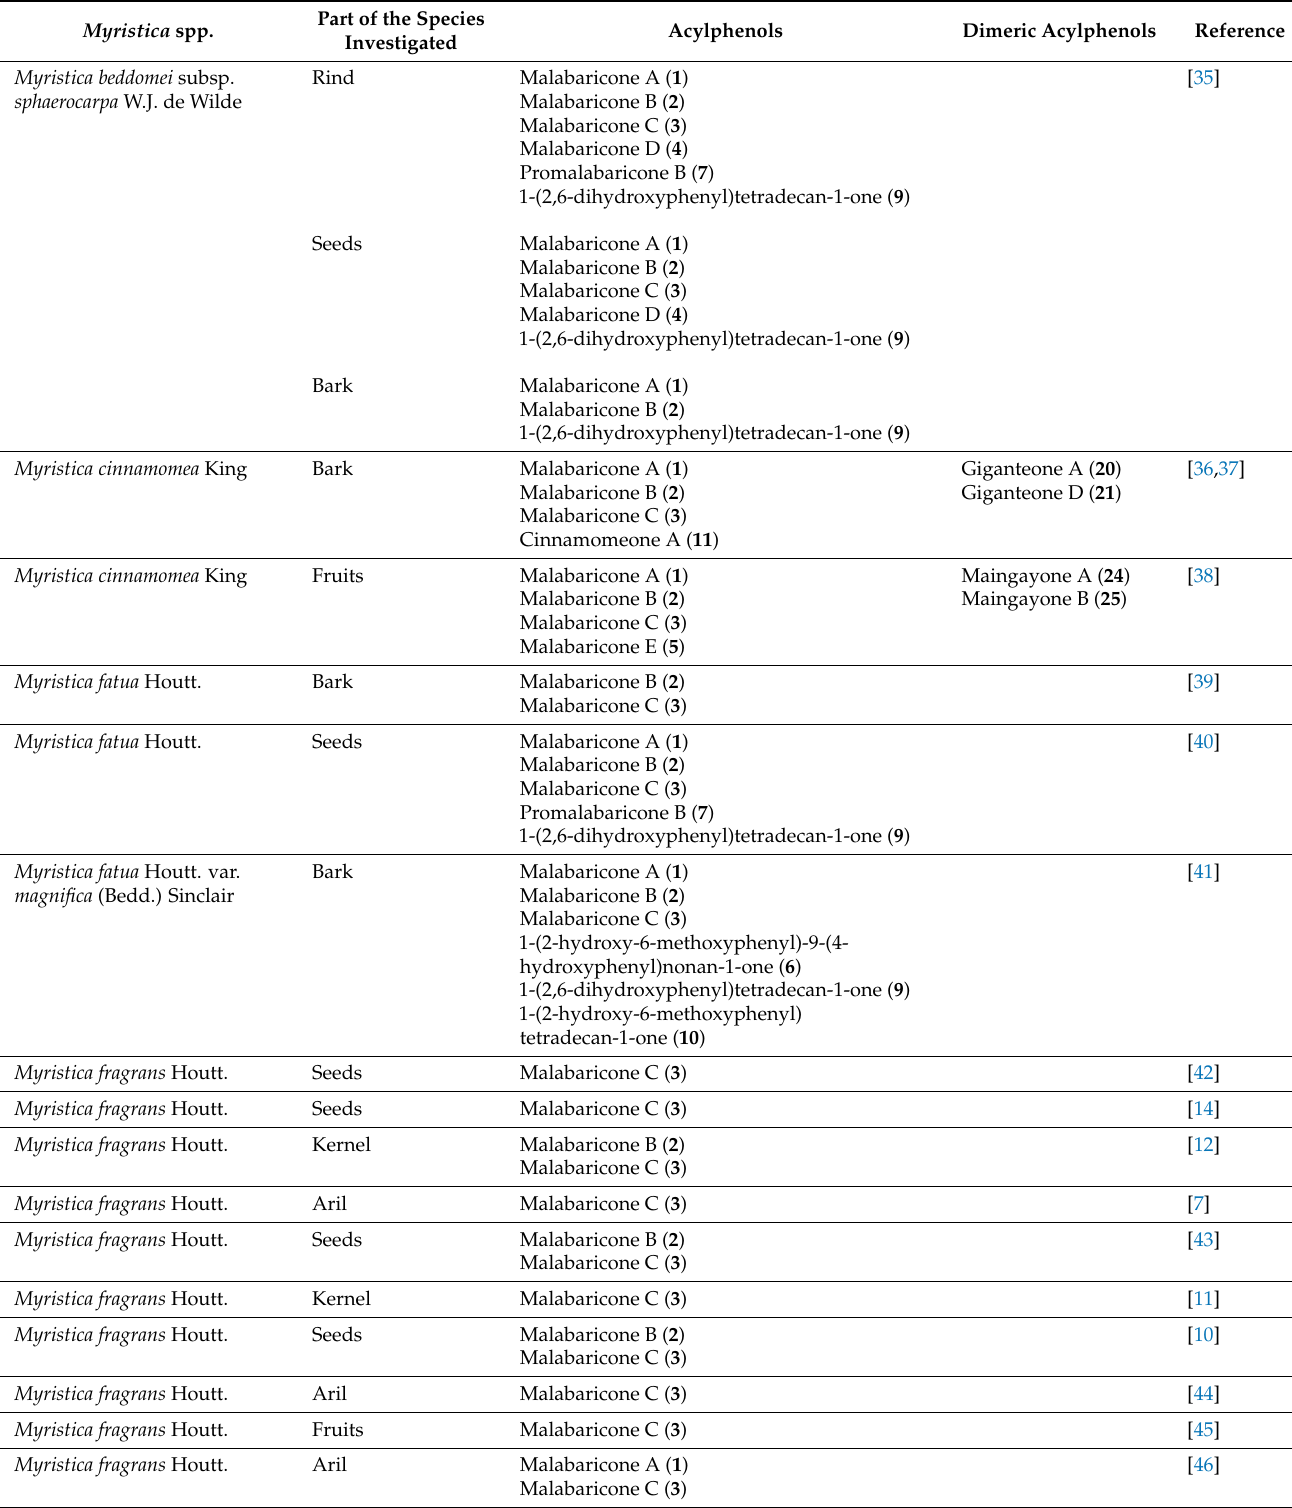
Table 1. Distribution of acylphenols and dimeric acylphenols within the genus Myristica